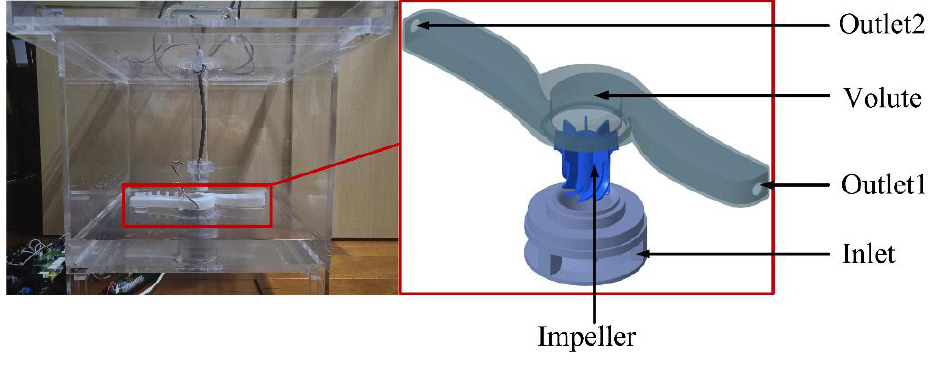
Figure 1. Open test rig of the dishwasher pump.